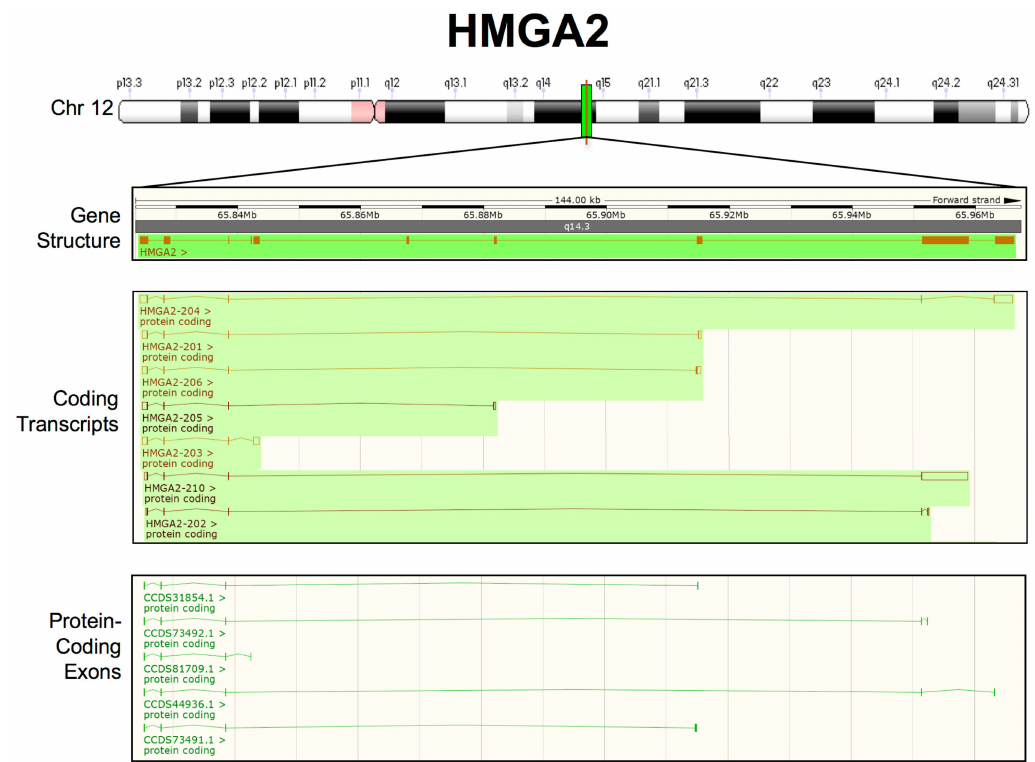
Figure 2. Updated human HMGA2 transcripts structure from the Ensembl Genome Browser (GRCh38.p13-GCF_000001405.39). From top to bottom: chromosome 12 (Chr 12) labelled with chromosome bands (white, black, and grey), centromeres (pink), and the HMGA2 locus (green); the HMGA2 gene structure, showing the overall length of the region considered, the location on Chr 12 (NC_000012.12):65,823,216–65,968,410, the chromosome band (q14.3) and HMGA2 exons / introns (orange boxes / lines); and, HMGA2 coding transcripts. The empty boxes indicate UTRs, whereas the filled boxes indicate ORFs. Merged Ensembl / Havana and Ensembl protein-coding data are shown in orange and brown, respectively; HMGA2 protein-coding exons are highlighted in